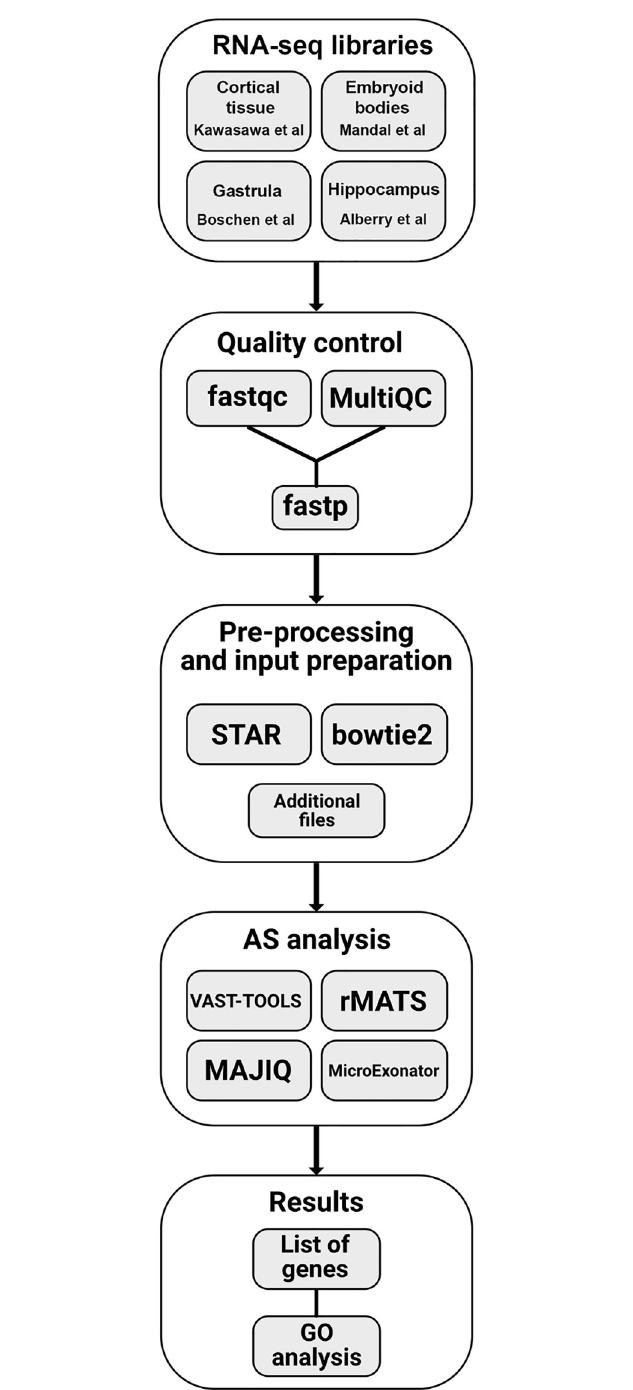
Fig 1. Flow diagram of the data processing. The diagram starts with the four analyzed RNA-seq libraries depicted in the first step, associated with the names of their authors. The second step ‘Quality Control’ shows the software employed for quality check and filtering of the library reads. The output of this step is used as input for ‘Pre-processing and input preparation’, which includes two main software programs required for the Sequence Alignment Map (SAM) file preparation and other additional file requirements. These files are the input for the selected alternative splicing (AS) tools. The ‘AS analysis’ step contains the execution of the selected AS software. Lastly, the ‘Results’ step includes the Gene Ontology (GO) analysis of the genes that show an AS